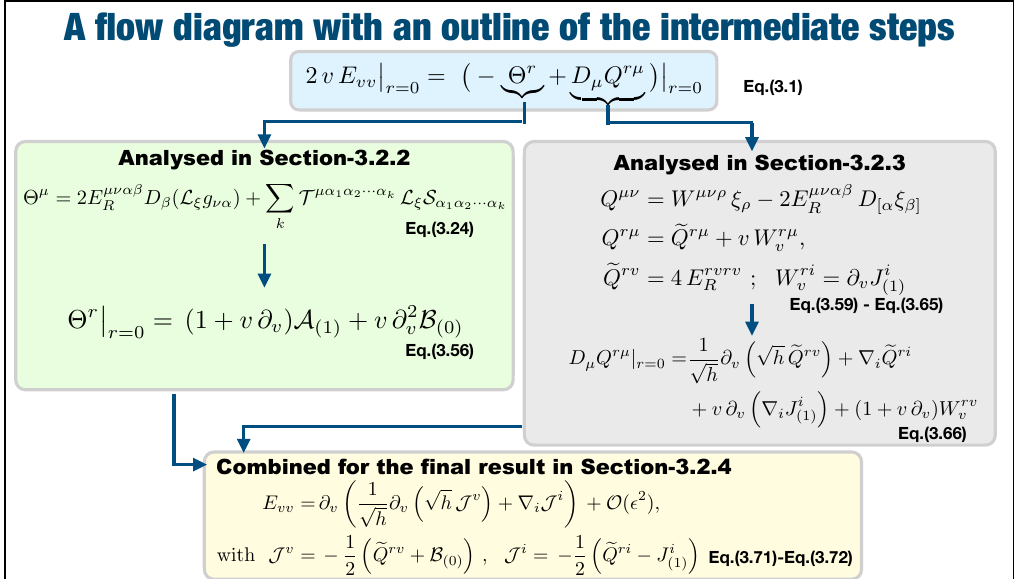
Figure 1 . A flow diagram summarising the main technical result in each